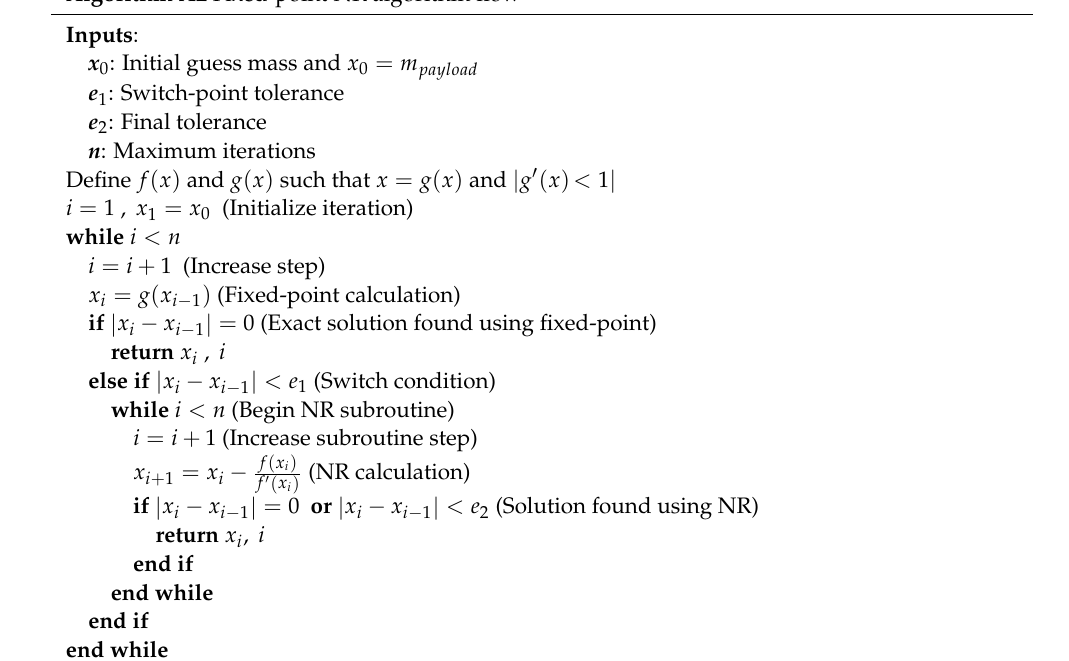
Algorithm A2 Fixed-point NR algorithm flow